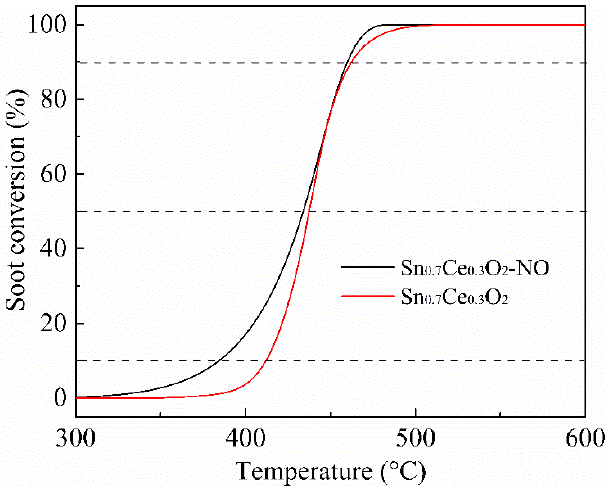
Figure 15. TPO profile of the effect of 1000 ppm NO on the Sn 0.7 Ce 0.3 O 2 fiber